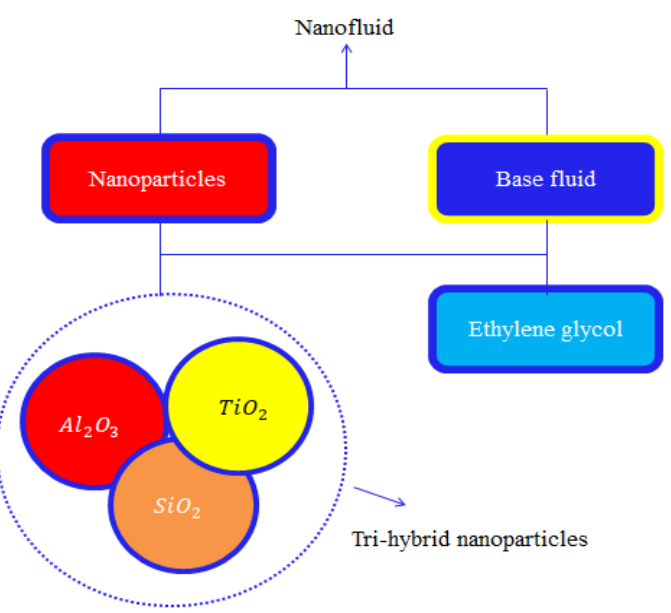
Figure 1. A description of the tri-hybrid approach in nanofluids.